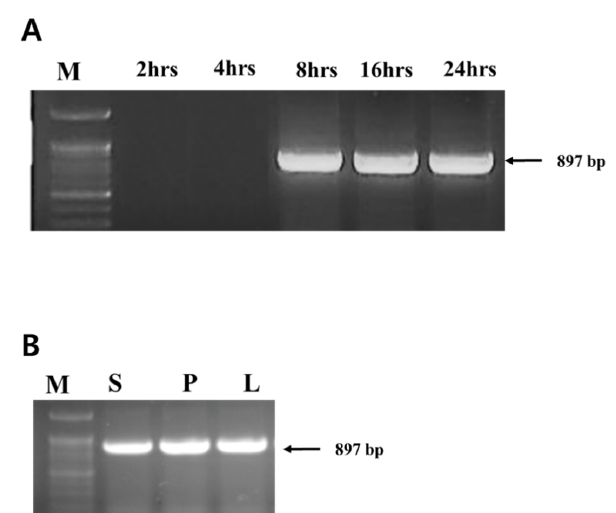
Figure 1. Detection of phage ACPWH in melon tissues. DNA was extracted from leaf tissues collected 2 h, 4 h, 8 h, 16 h, and 24 h post-inoculation of phage to soil ( A ), tissues 8 h post-inoculation ( B ), and amplified by PCR. M, 100 bp marker; S, stem; P, leaf petiole; L, leaf blade.